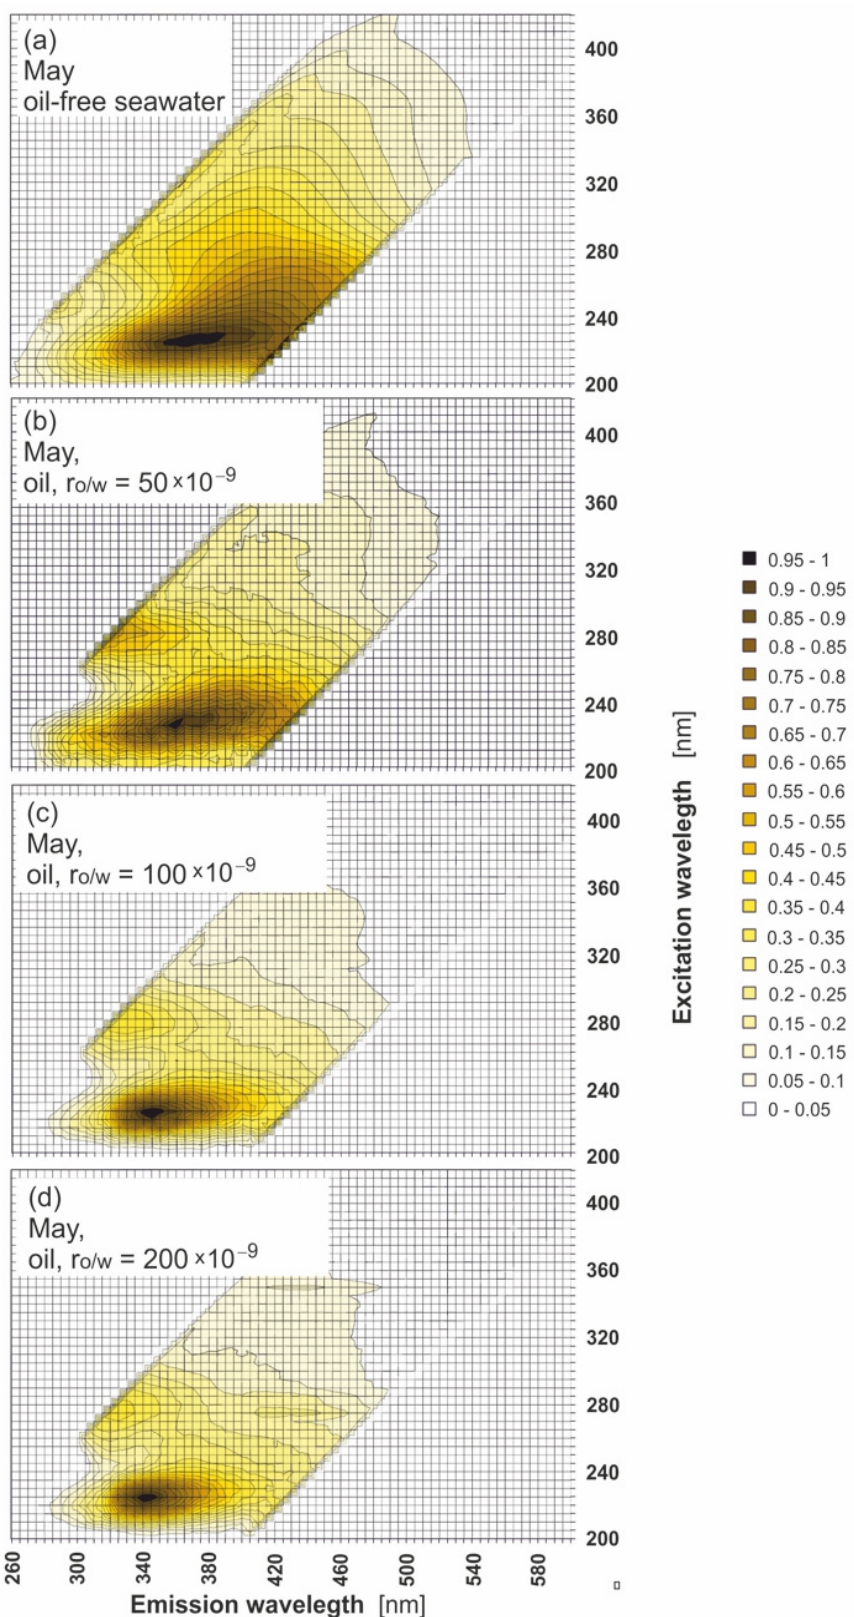
Figure 7. Excitation–emission spectra of oil-free seawater ( a ) in comparison with the excitation–emission of seawater polluted with oil but after deducting the oil-free water fluorescent component ( b – d ).